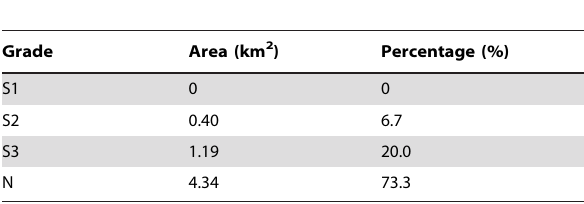
Table 7. Areas of land suitable for growing crops in the Liudaogou